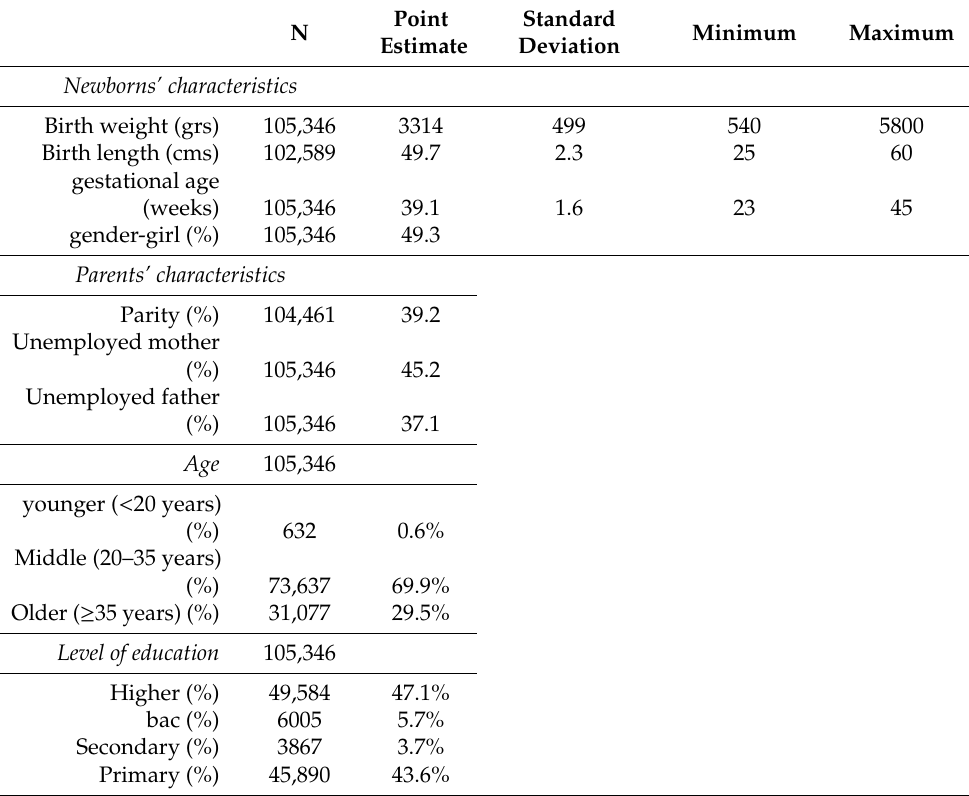
Table 1. Descriptive statistics for newborns’ and parents’